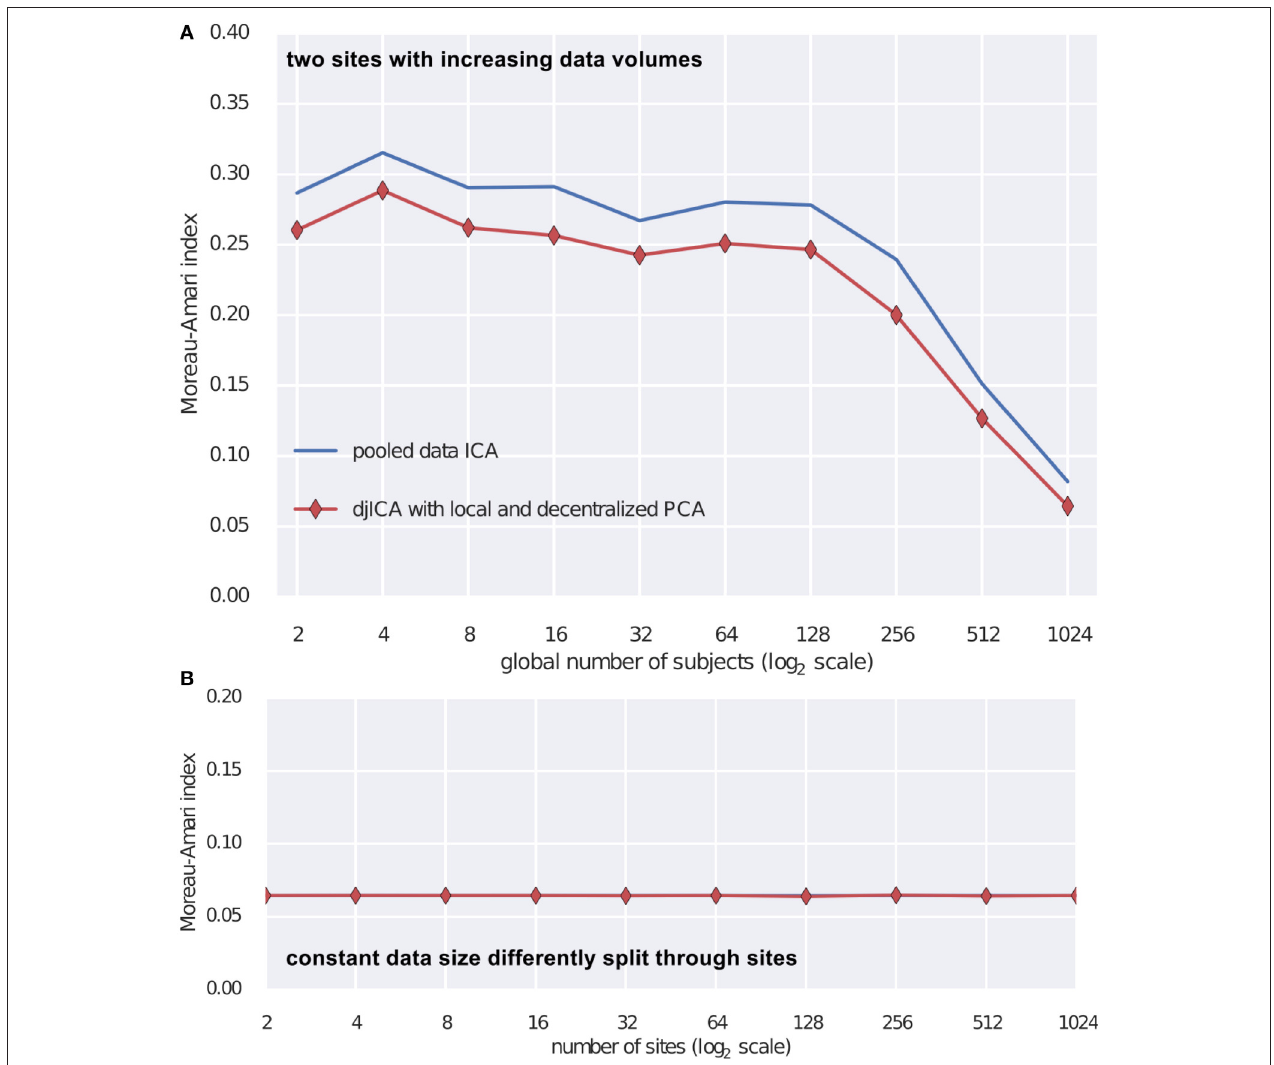
FIGURE 3 | Comparison of djICA ISI with that of pooled data ICA. (A) Effect of increasing the number of subjects in an experiment with two sites. Distributed ICA has performance competitive with centralized ICA even though the data is split across different sites and only derivatives are shared. (B) Effect of splitting a total subject pool of 2048 subjects among an increasing number of sites. There was no visible change in performance despite the data being